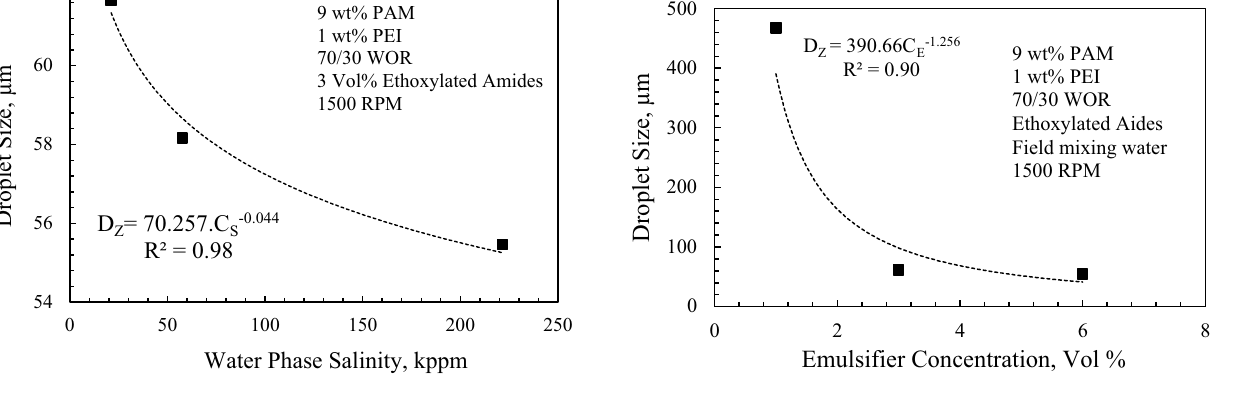
Fig. 4 Droplet size of the emulsified gels for different salinities at 25 °C, as measured by LPSA